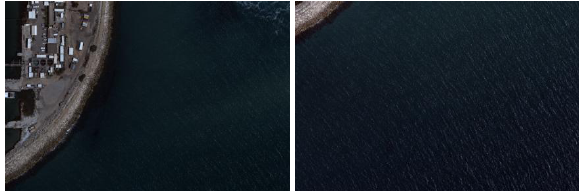
Figure 5a: Water with small objects: source (l.) and. target (r.).